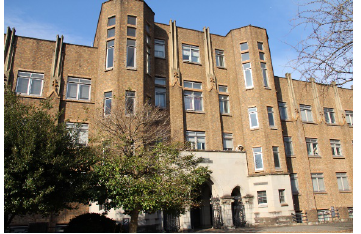
Figure 2. Image taken at ground level